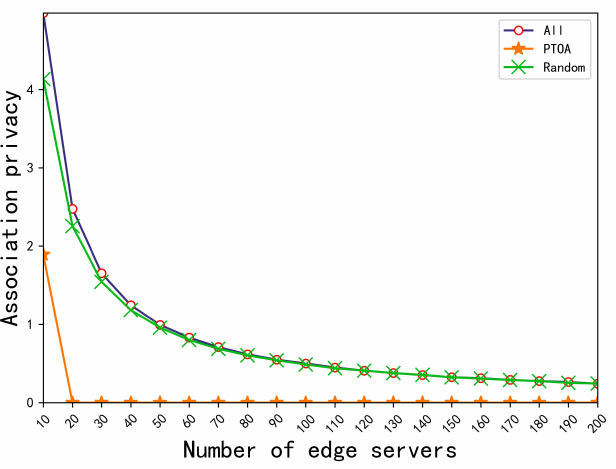
Figure 5. Comparison of the association privacy-preserving ability for three different strategies, All, Random, and PTOA, with a different number of edge